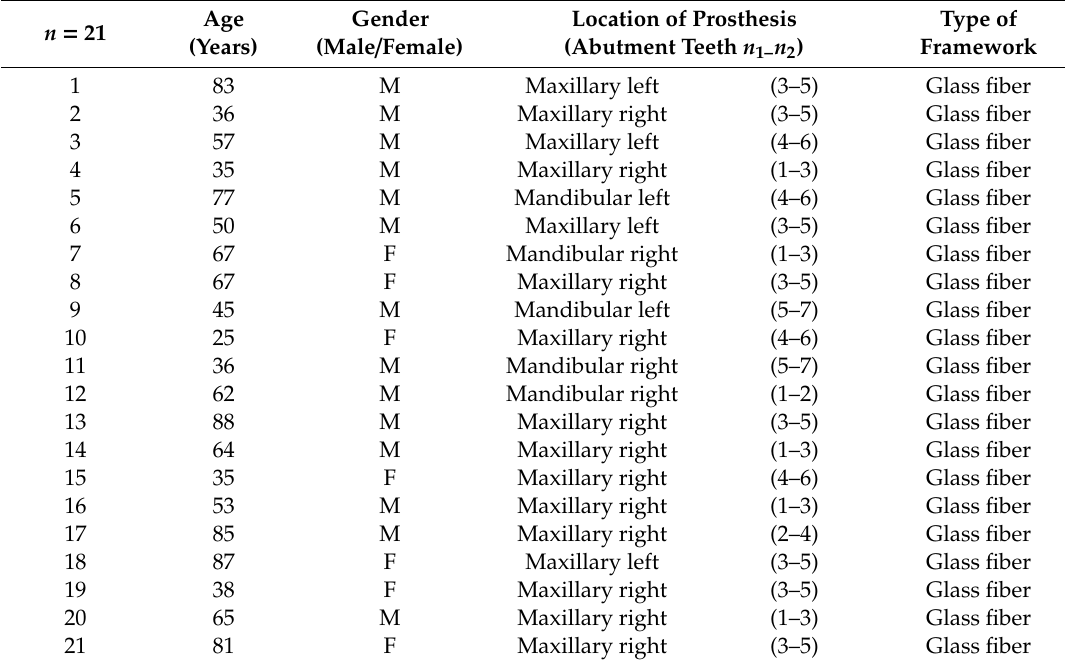
Table 1. Description of the patients and the prostheses.